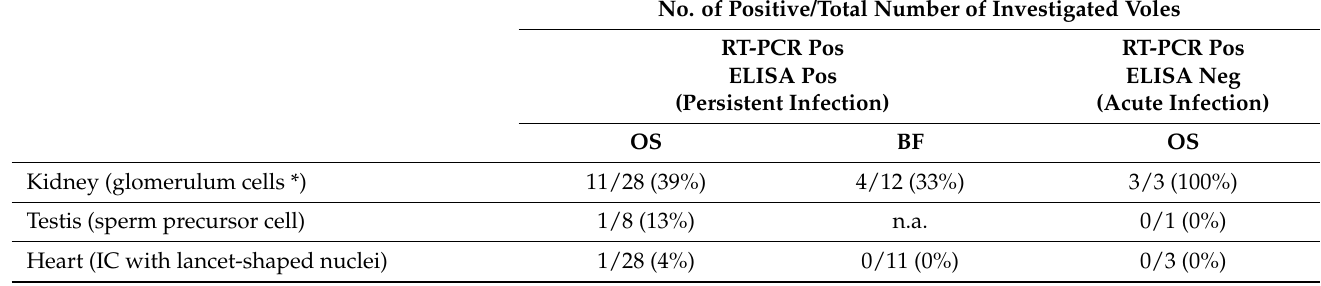
Table 1. Cont. No. of Positive/Total Number of Investigated